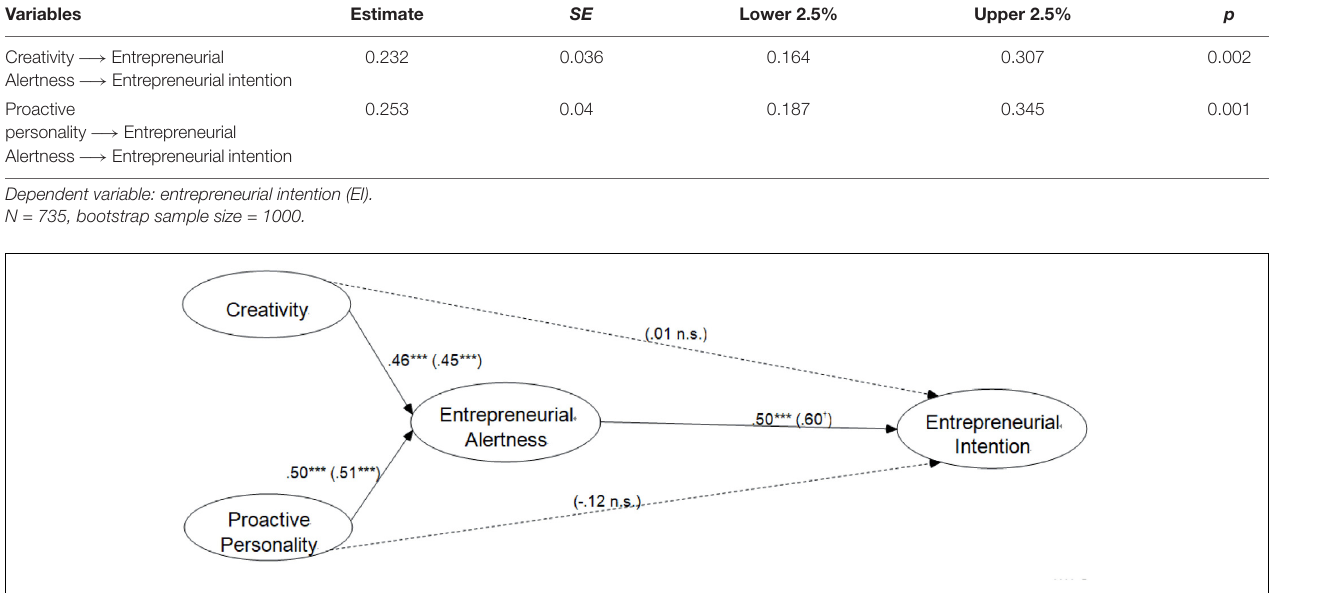
FIGURE 2 | Estimated path coefficients of the structural equation model. The numbers represent the beta coefficients for Model 1. The beta coefficients for Model 2 are in parentheses. † Marginal significant. ∗∗∗ p < 0.001. TABLE 4 | Comparison of structural equation models (Models 2 and 3).